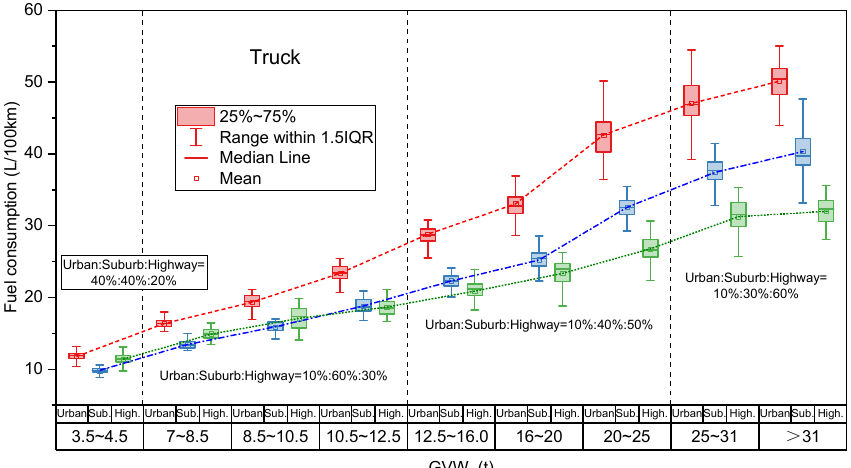
Figure 14. Fuel consumption of different cycle parts (truck).